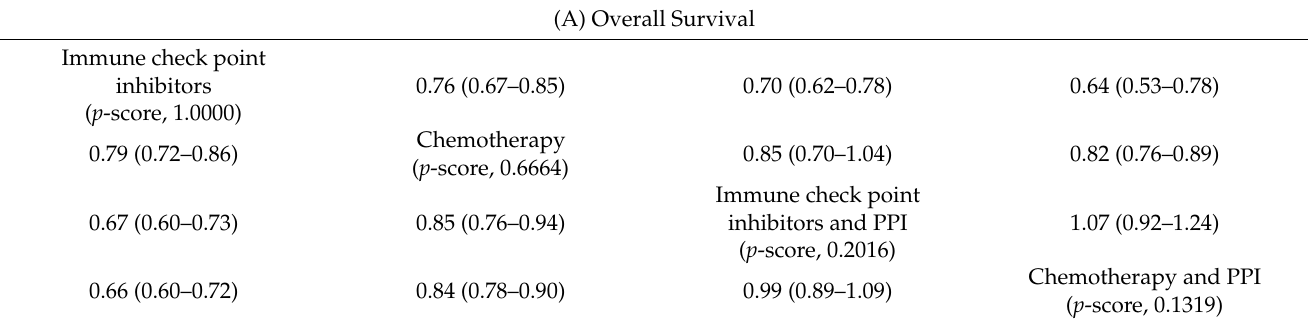
Table 2. League table of pairwise comparisons in the network for the hazard ratio (with 95% CIs) of OS (A) and PFS